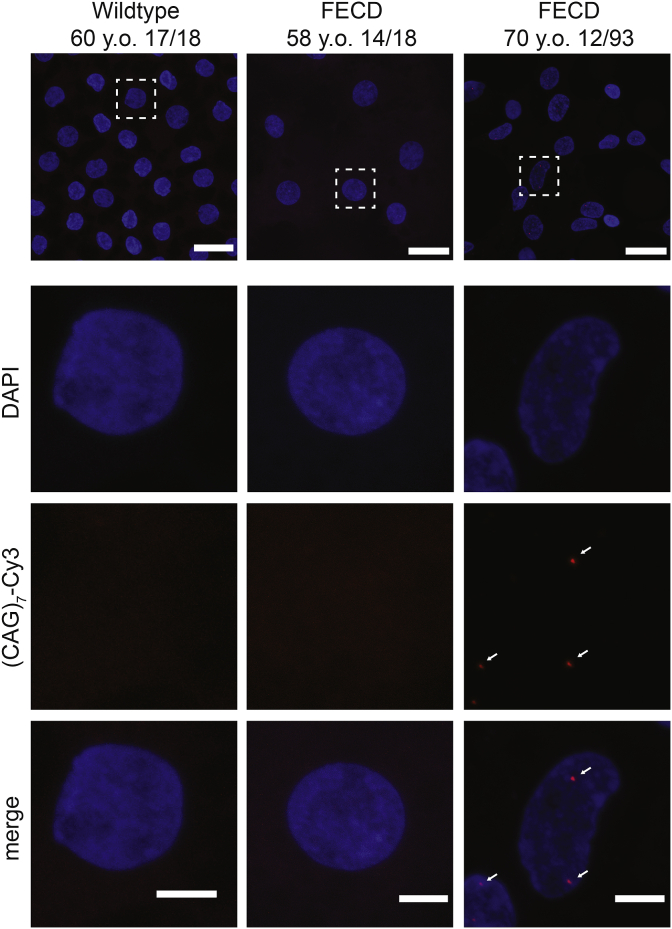
Representative fluorescence in situ hybridization (FISH) images of healthy control, CTG18.1 expansion-negative Fuchs endothelial corneal dystrophy (FECD) and CTG18.1 expansion-positive FECD corneal explant tissue. (CUG)n RNA foci detection was performed using Cy3-(CAG)7 probe using methods adapted from Zarouchlioti et al., (2018). White arrows highlight RNA foci within the CTG18.1 expansion-positive endothelium. y.o., years old. Scale bar for multiple nuclei, 20 μm (top panel). Single nuclei, 5 μm (lower panels).